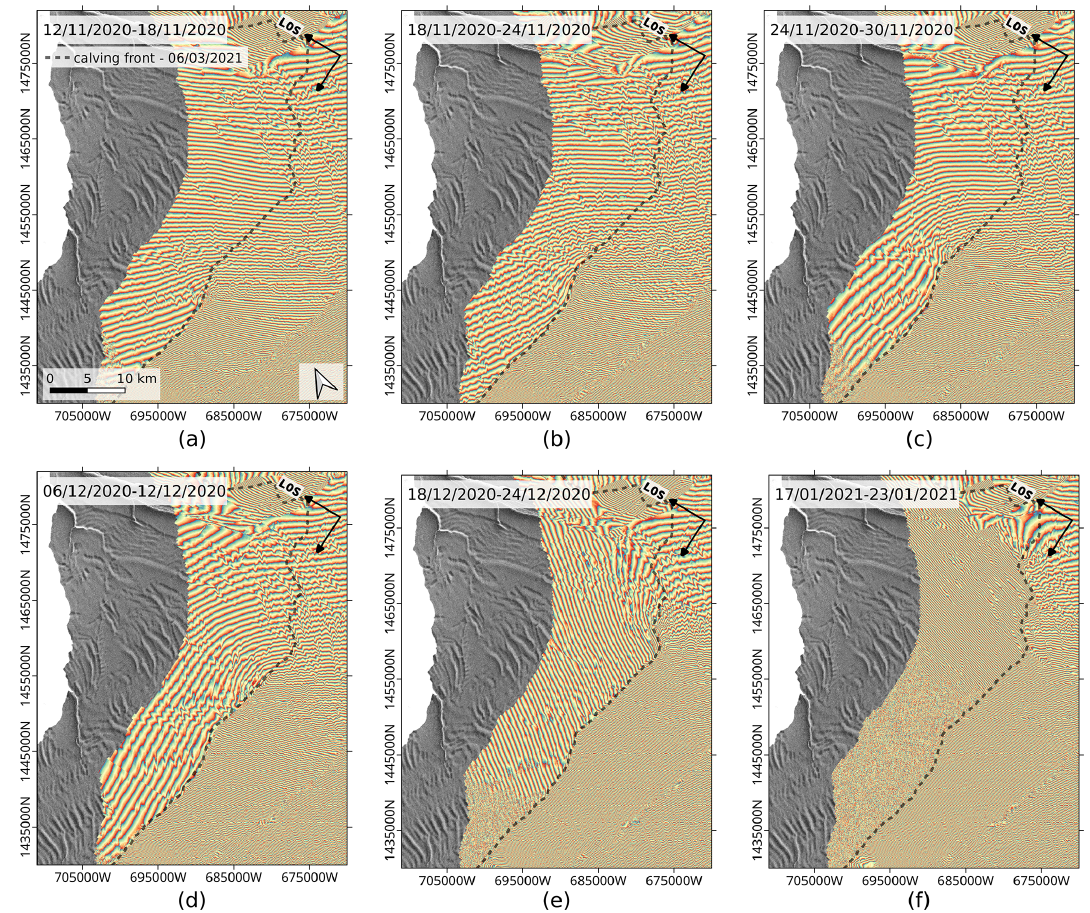
Figure 7. Time series of wrapped repeat-pass interferograms showing the phase ramp variation from one date to another, as the North Rift propagates between November 2020 and January 2021. The black dashed line indicates the full extent of the North Rift, manually delineated from the calving front on 6 March 2021, after the A74